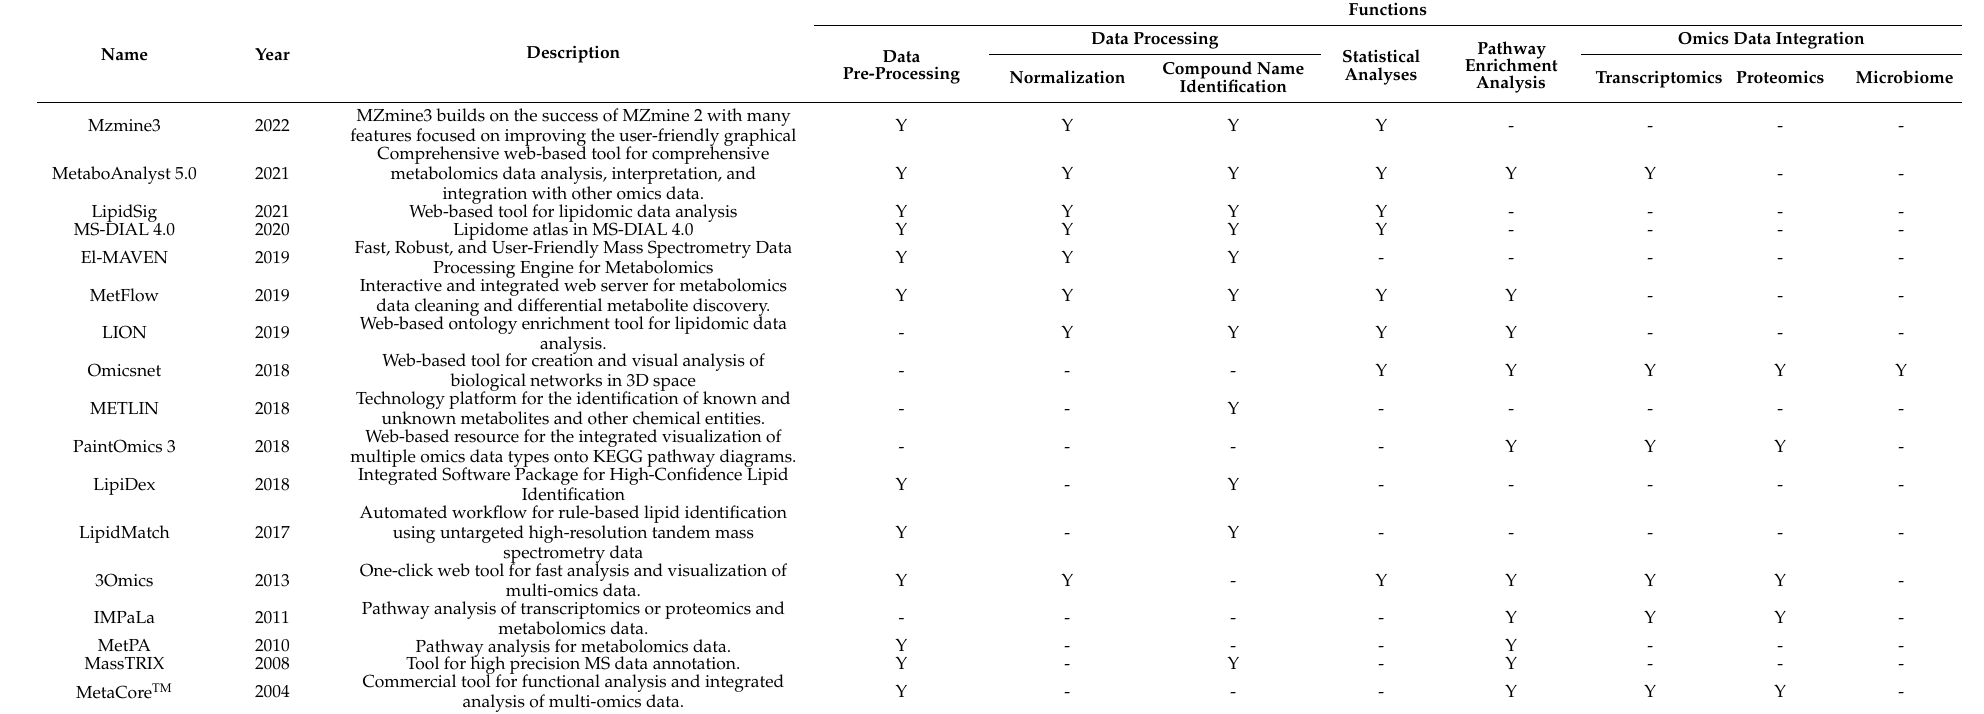
Table 1. Features of several most used metabolomics data analysis